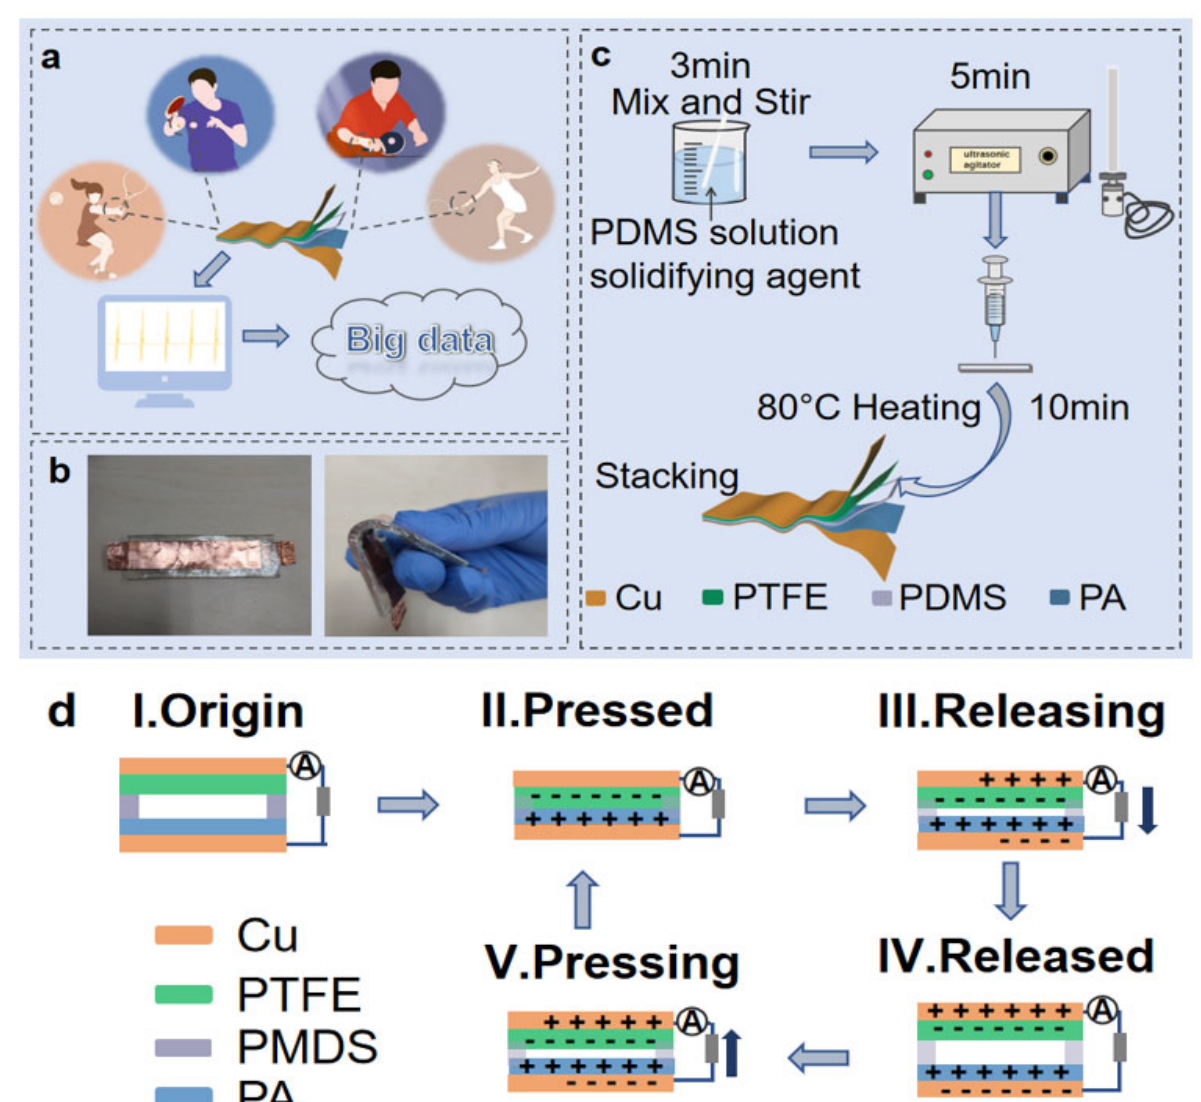
Figure 1. Design and application of LS ‐ TENG. ( a ) Application of LS ‐ TENG in motion scene. ( b ) LS ‐ TENG optical image. ( c ) Preparation process of LS ‐ TENG. ( d ) Schematic diagram of the LS ‐ TENG.